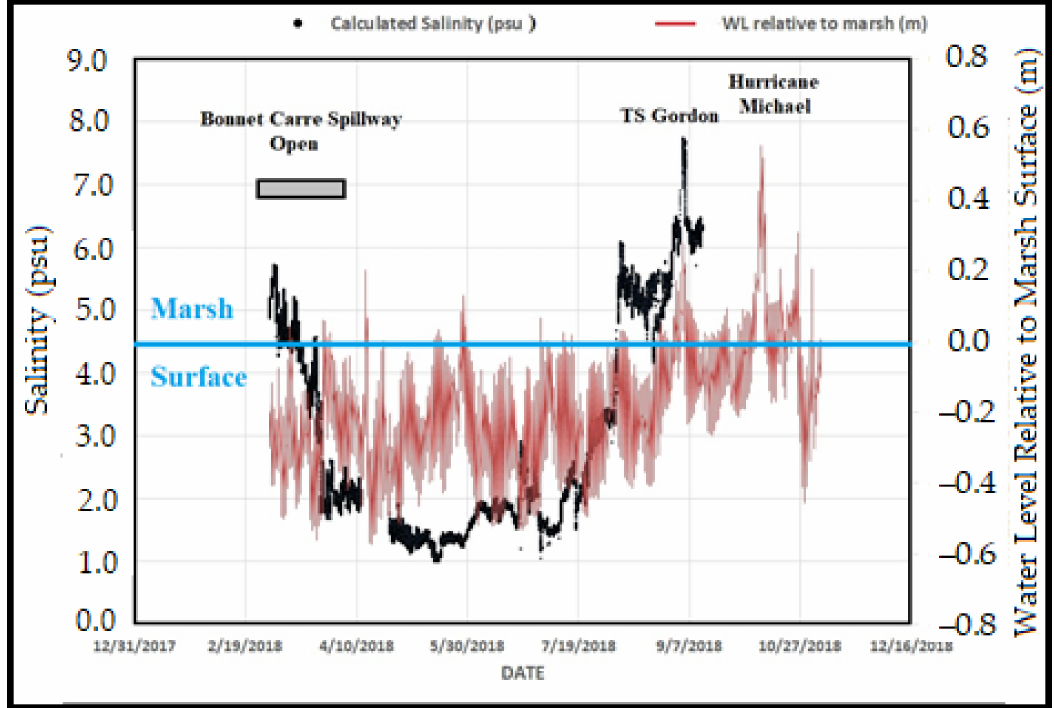
Figure 8. Continuous salinity (black) and water level (red) relative to marsh elevation at Site A1b (Figure 2) on the shore of Lake Borgne from 2 March to 4 November 2018. The one-month Bonnet Carr é Spillway opening (gray bar) in March lowered salinity in southern Lake Borgne almost 6 psu to between 1 and 2 psu through early July. Salinity rose with water level in the fall despite a modest increase in Mississippi River discharge. Tropical cyclones coming ashore in Mississippi (T.S. Gordon 9/4) and on the Florida panhandle (H. Michael 10/13) briefly pushed 0.3 and 0.5 m, respectively, of saltier water into Lake